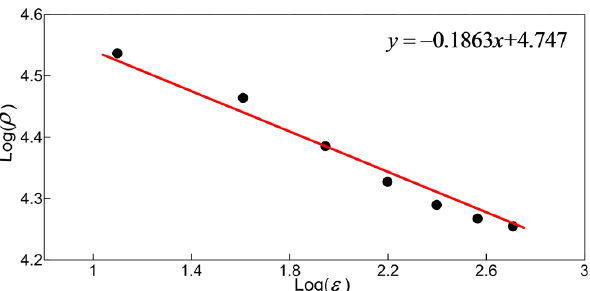
Fig. 9. Log–log (base 10) plot showing the relationship between the concentration values ρ(ε) and the box size ε centred at point n in Fig. 7.